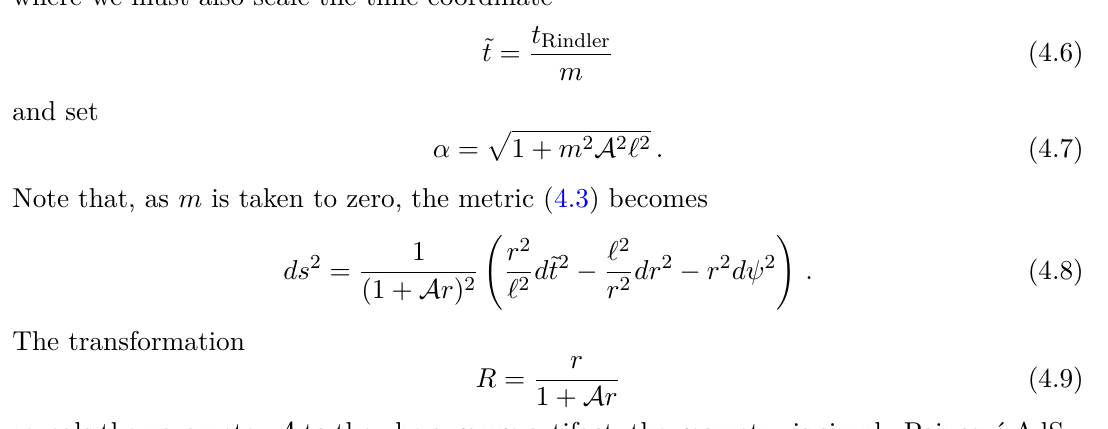
JHEP05(2022)063